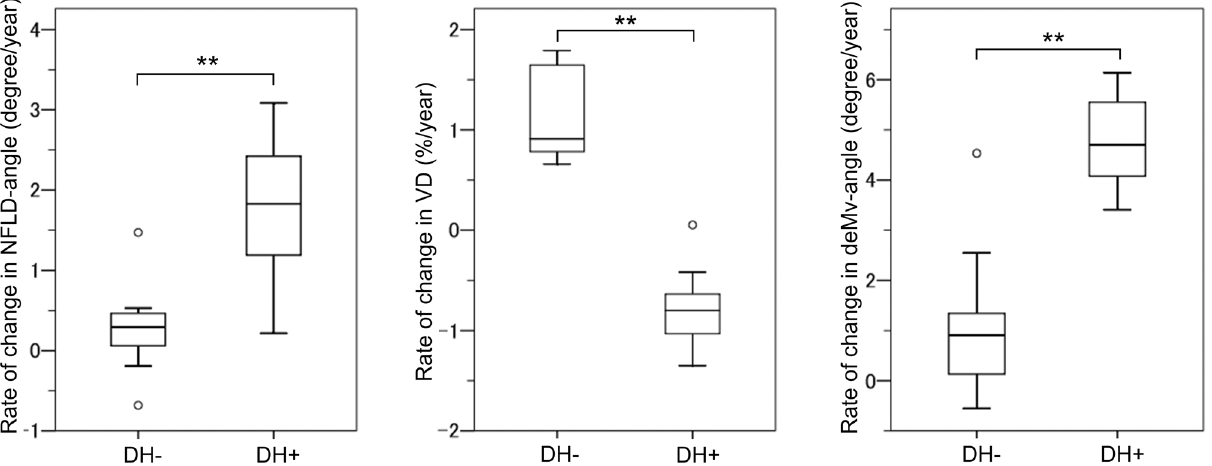
Figure 2. Box plots illustrating the distribution of the rates of changes in NFLD-angle (degree/year), VD (%/ year), and deMv-angle (degree/year). Rates of changes in NFLD-angle and deMv-angle are adjusted by IOP, and the rate of VD change is adjusted by IOP and SSI. The medians are represented by horizontal lines in the white boxes. Boxes represent the interquartile range between the first and third quartiles. ** P -value <